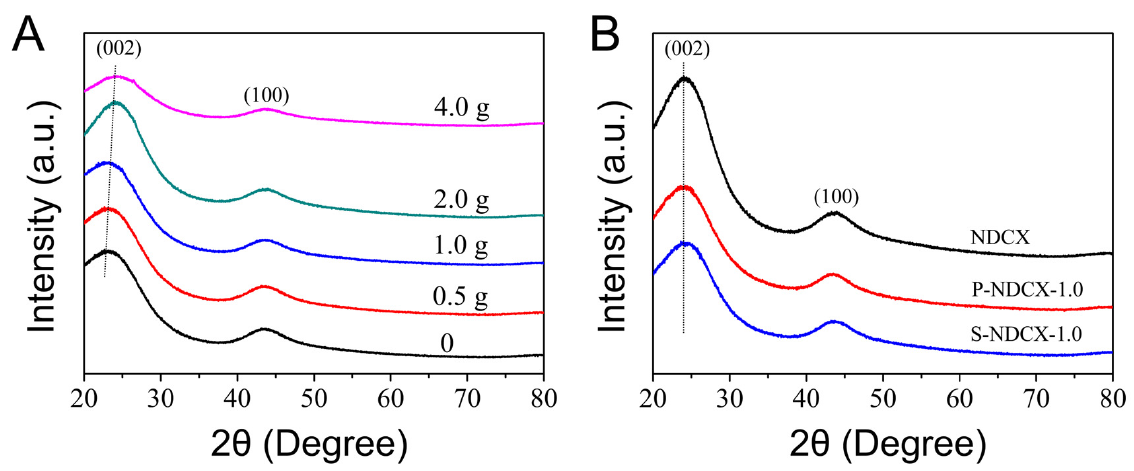
Figure 1. XRD patterns of ( A ) N ‐ doped carbon xerogels prepared with 0–4.0 g of dicyandiamide and ( B ) NDCX, P ‐ NDCX ‐ 1.0, and S ‐ NDCX ‐ 1.0. ( B ) NDCX, P-NDCX-1.0, and